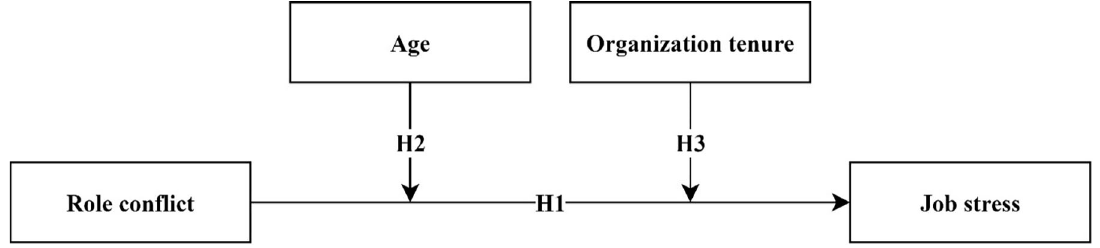
Figure 1. Conceptual framework of the